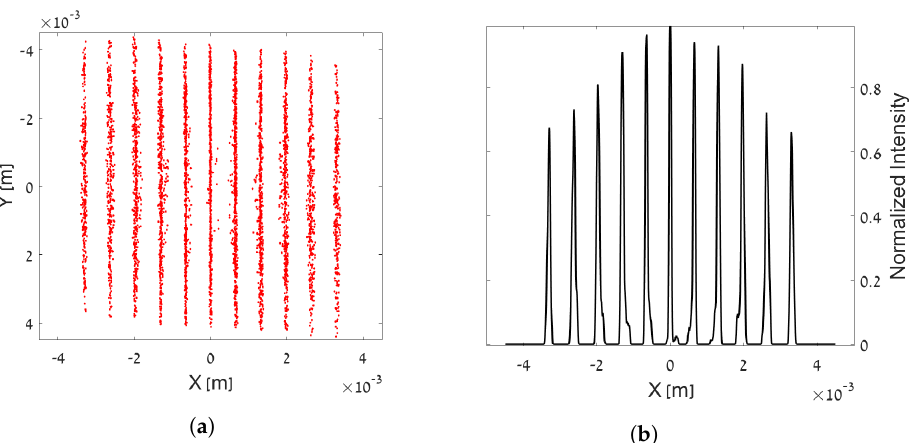
Figure 3. ( a ) Mock image exported from GPT, which represents the captured image from the YAG crystal. ( b ) Conversion of the mock image into a continuous